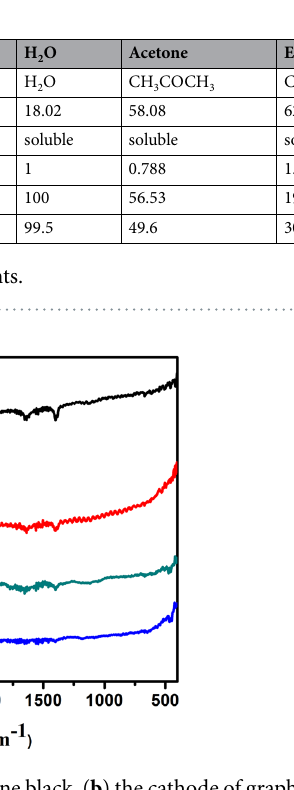
Figure 2. FTIR spectra of ( a ) acetylene black, ( b ) the cathode of graphite, ( c ) graphite oxide and ( d )